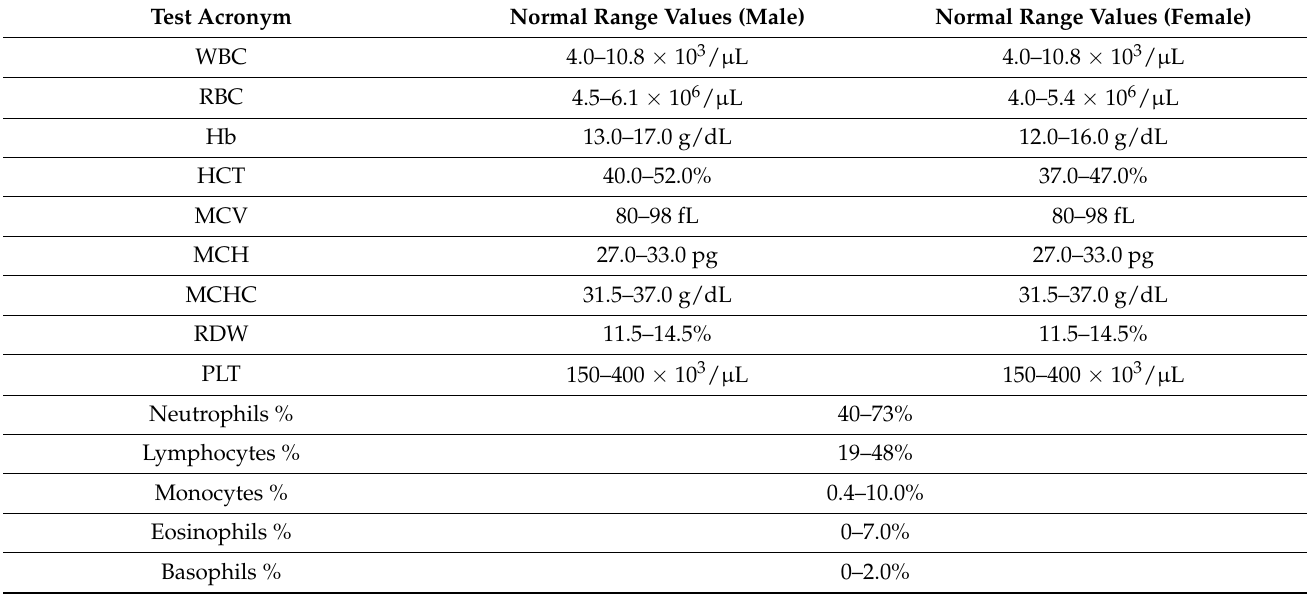
Table 1. Complete blood count with white blood cell differential